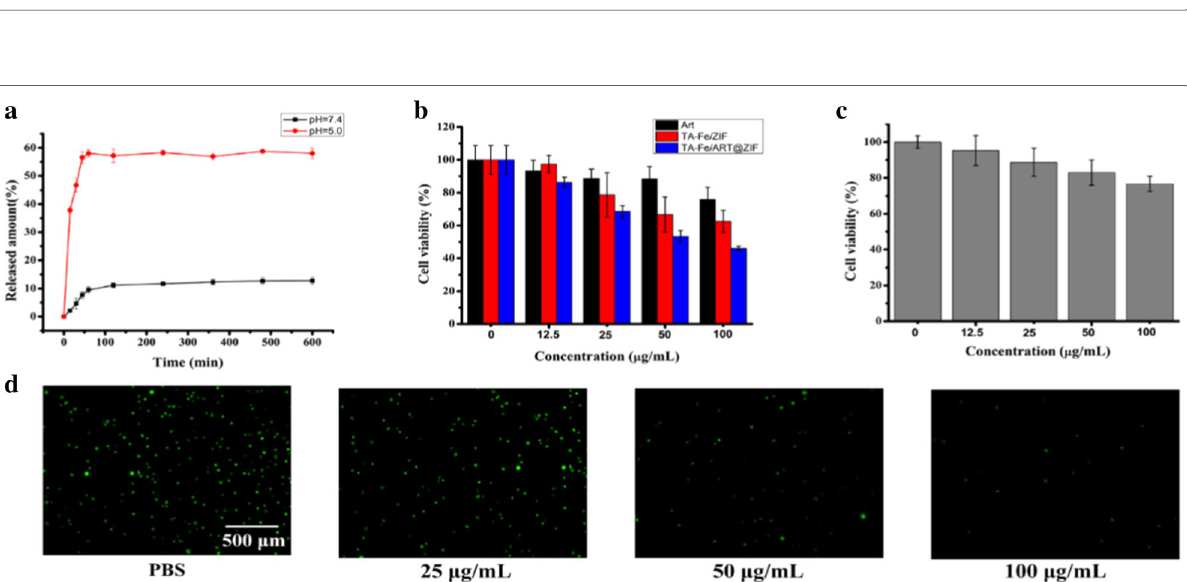
Fig. 3 a TEM images and size distribution of ZIF-8, ART@ZIF, and TA-Fe/ ART@ZIF nanoparticles. Scale bar: 100 nm; b distribution of carbon and iron element in TA-Fe/ ART@ZIF nanoparticles. Scale bar: 100 nm